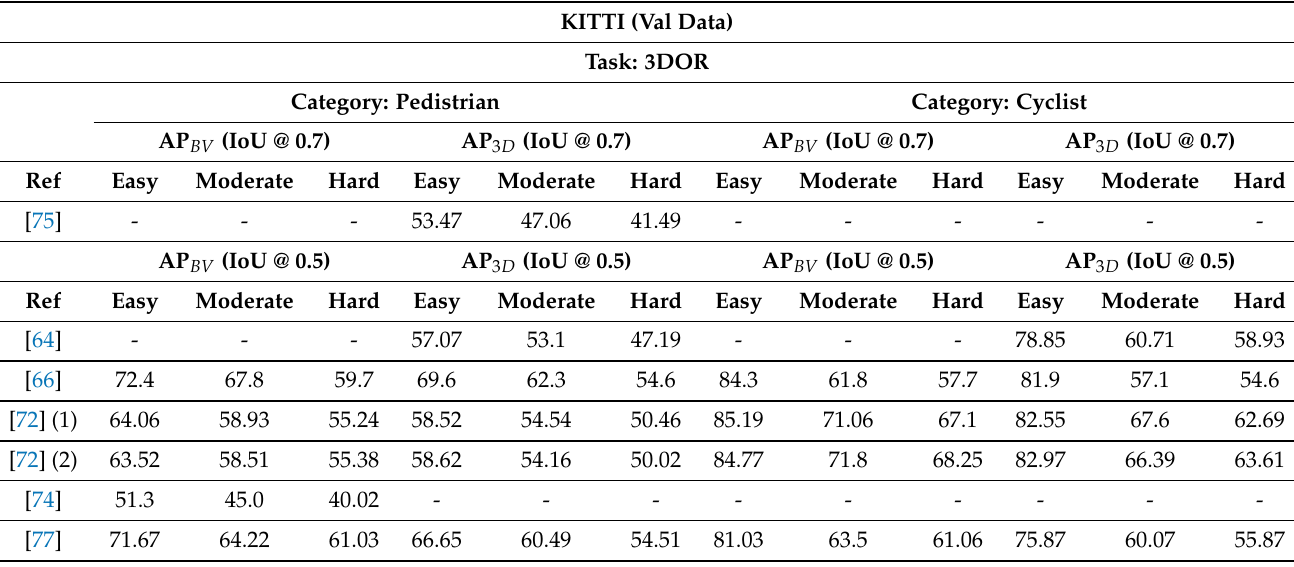
Table 23. Comparison of the Results on the KITTI Validation Dataset for the Pedestrian and Cyclist